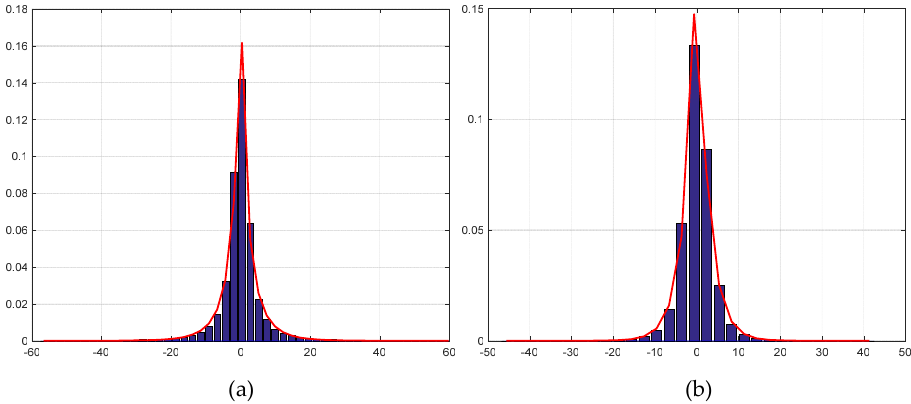
Figure 2. Wavelet sub-band coefficient histogram fitted with a Laplacian distribution. ( a ) Barbara; ( b )